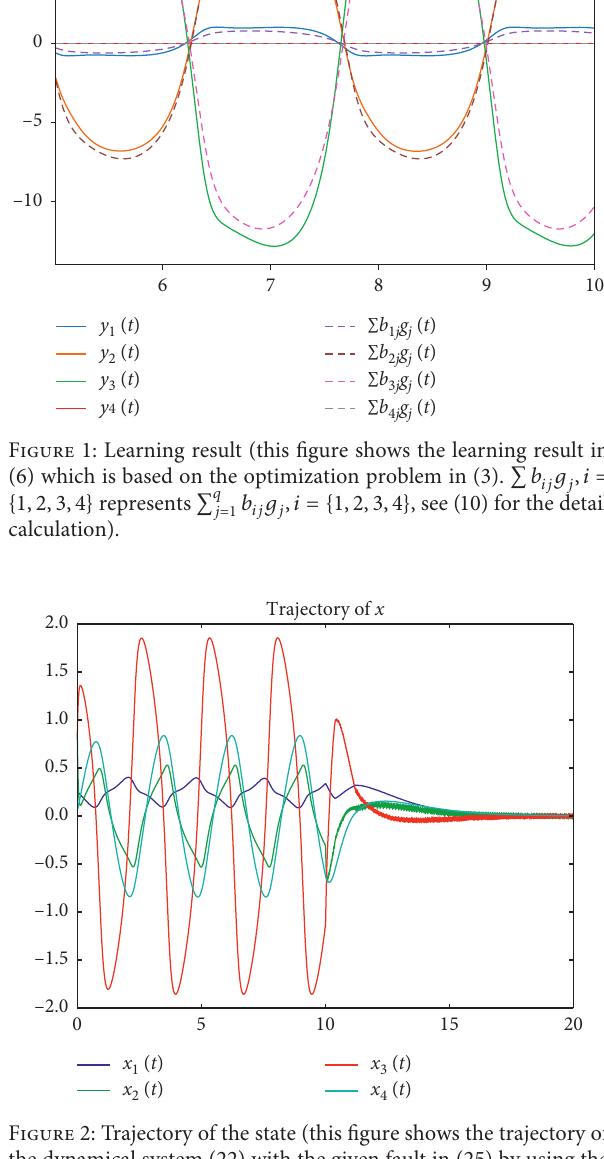
Figure 2: Trajectory of the state (this figure shows the trajectory of the dynamical system (22) with the given fault in (25) by using the proposed learning-based control in